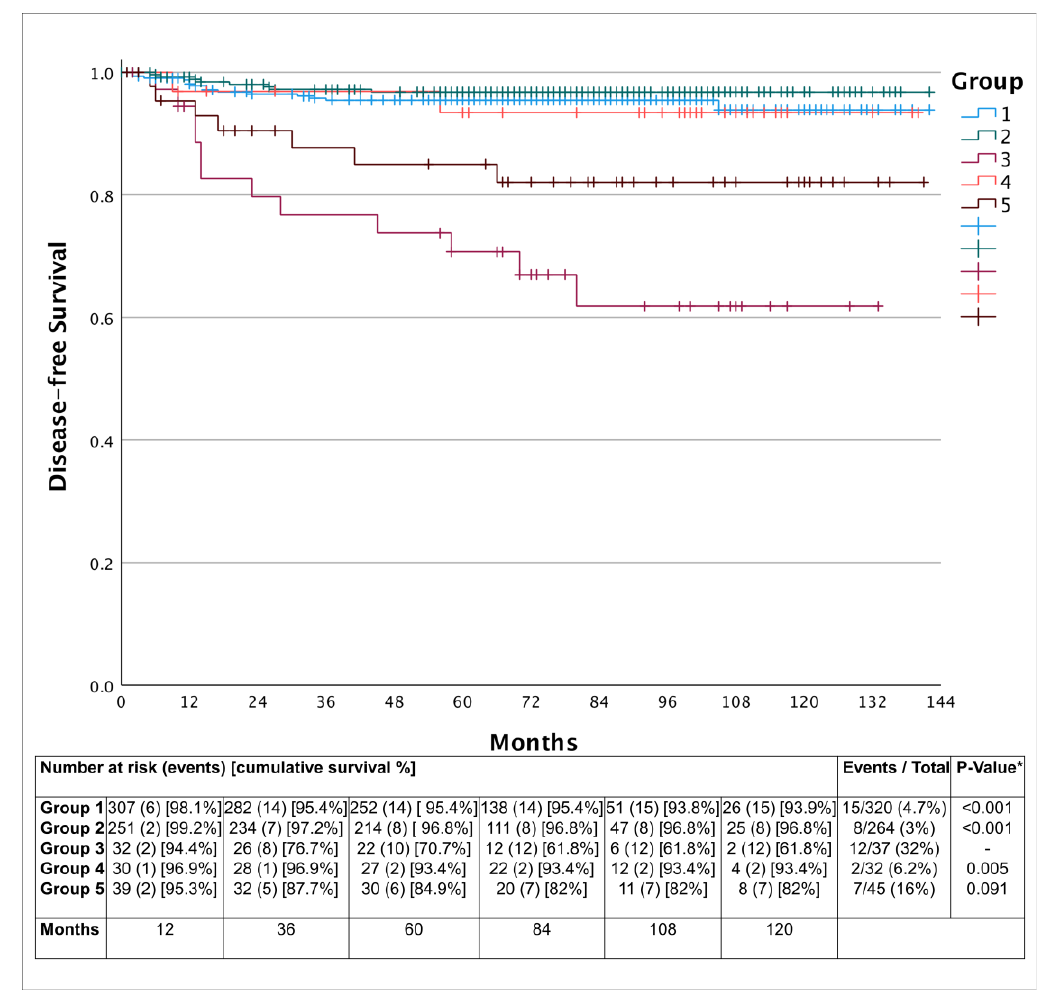
Figure 2. Kaplan–Meier’s curves demonstrating lower disease-free survival in the patients of Groups 3 and 5. Cumulative disease-free survival of 93.9% (15 events in 320 cases), 96.8% (8 events in 264 cases), 61.8% (12 events in 37 cases), 93.4% (2 events in 32 cases) and 82% (7 events in 45 cases), respectively for groups 1 to 5 (Group 3, p < 0.001 vs. Groups 1 and 2, p = 0.005 vs. Group 4 and p = 0.091 vs. Group 5 — * Log-Rank test). Note: Group 1: Total thyroidectomy without incidental lymph node resection; Group 2: Total thyroidectomy with incidental lymph node resection without lymph node metastasis; Group 3: Total thyroidectomy with incidental lymph node resection and lymph node metastasis; Group 4: Total thyroidectomy with central compartment neck dissection without lymph node metastasis; Group 5: Total thyroidectomy with therapeutic central compartment neck dissection (with lymph node metastasis).